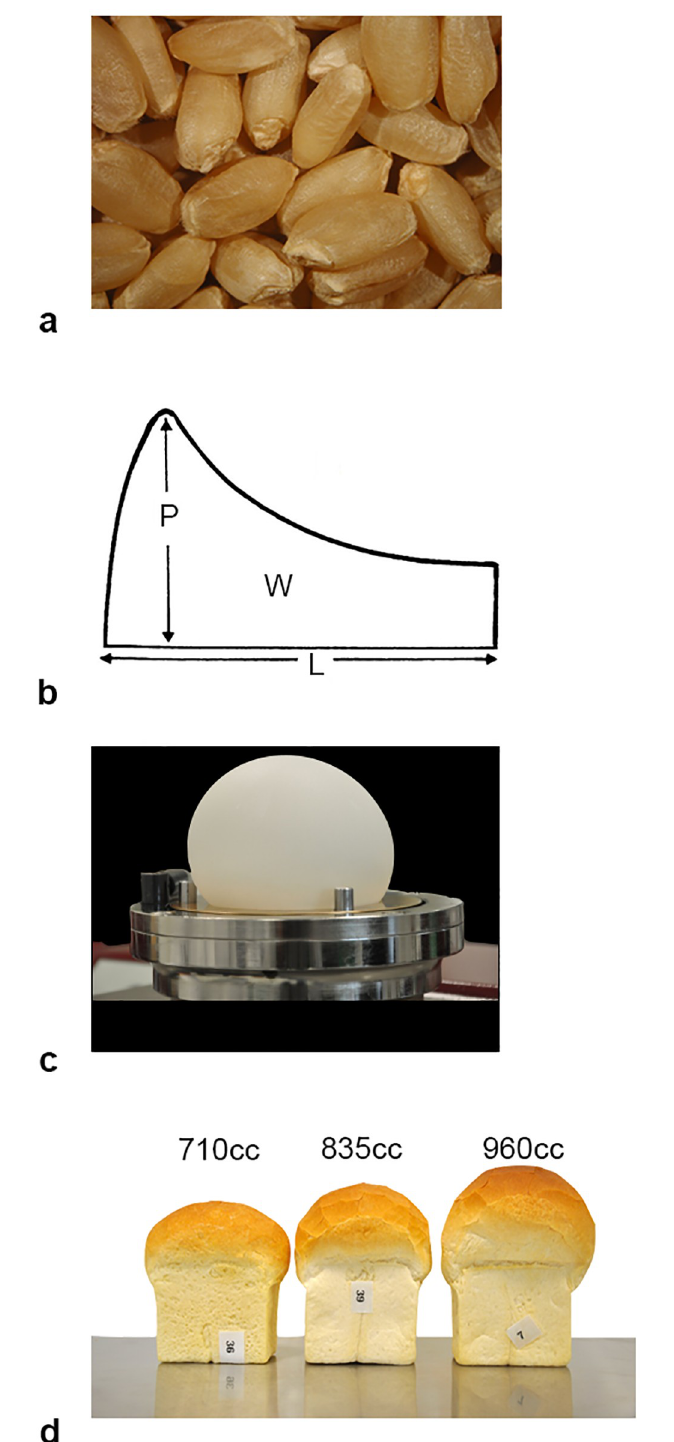
Fig 1. Demonstration and quantification of grain, dough and loaf volume tests. a) Grain samples for protein testing and milling, b) Alveograph example demonstrating that P/L is the height to width ratio which measures extensibility and W, area under the curve measures dough strength. These are measured on c) dough tested in forced air method of Alveograph. Loaf volume test is represented in d) with breeding lines of various volumes demonstrated.